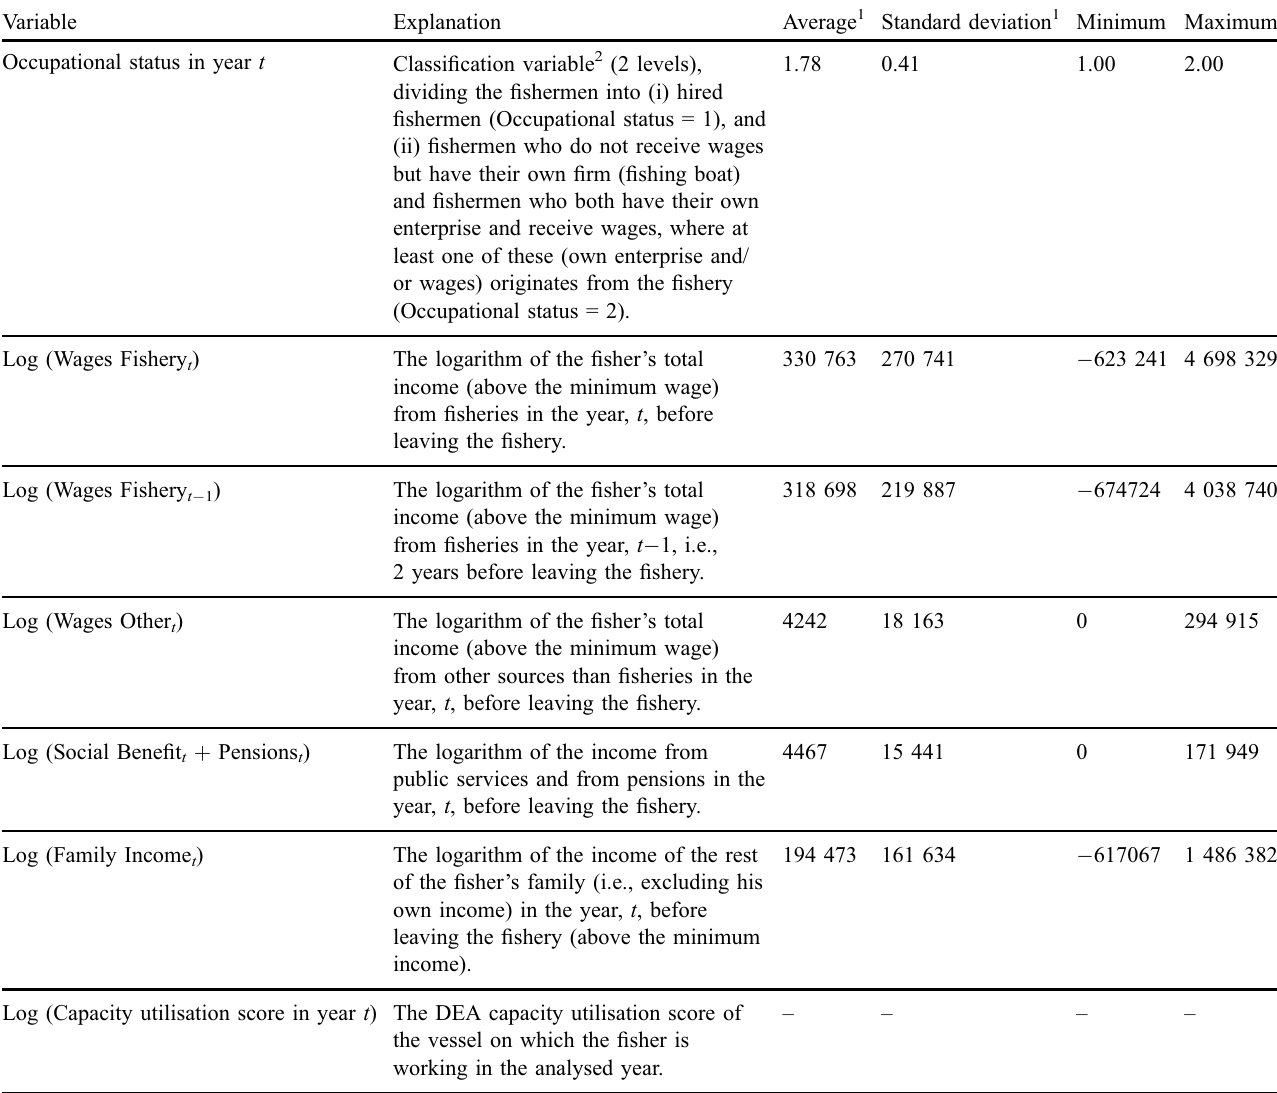
Table 3. Descriptive statistics over the period 2004 – 2009 for the explanatory variables applied in the logit analysis of factors that affect small-scale fi shermen ’ s decision to leave the fi shery.